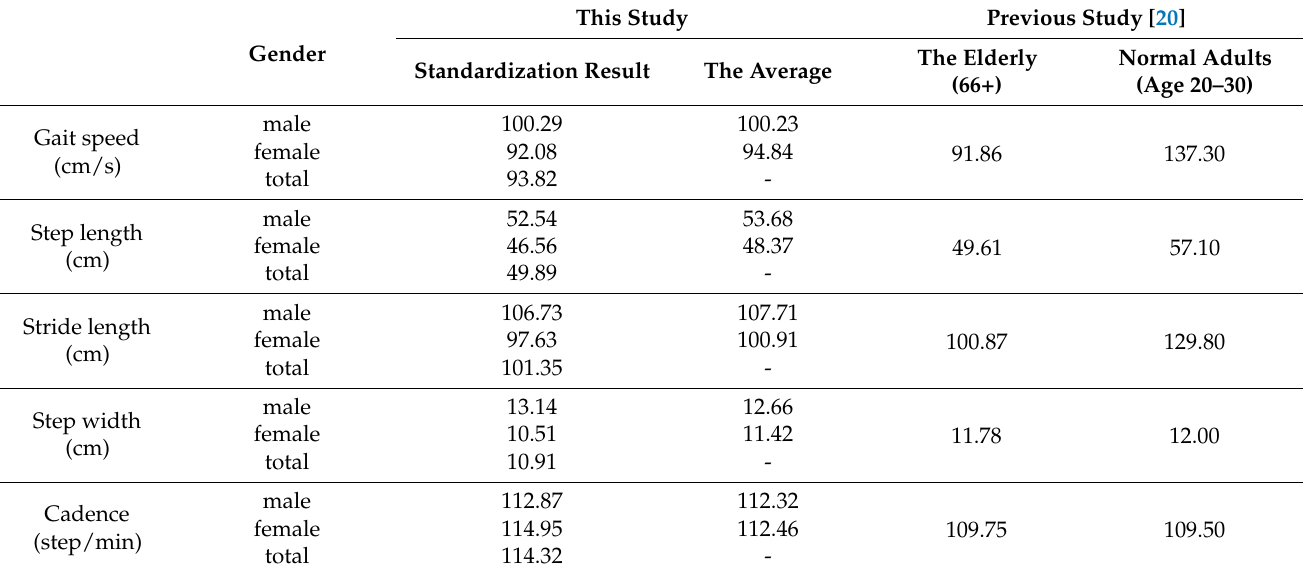
Table 8. Comparison of gait characteristics between the elderly and normal